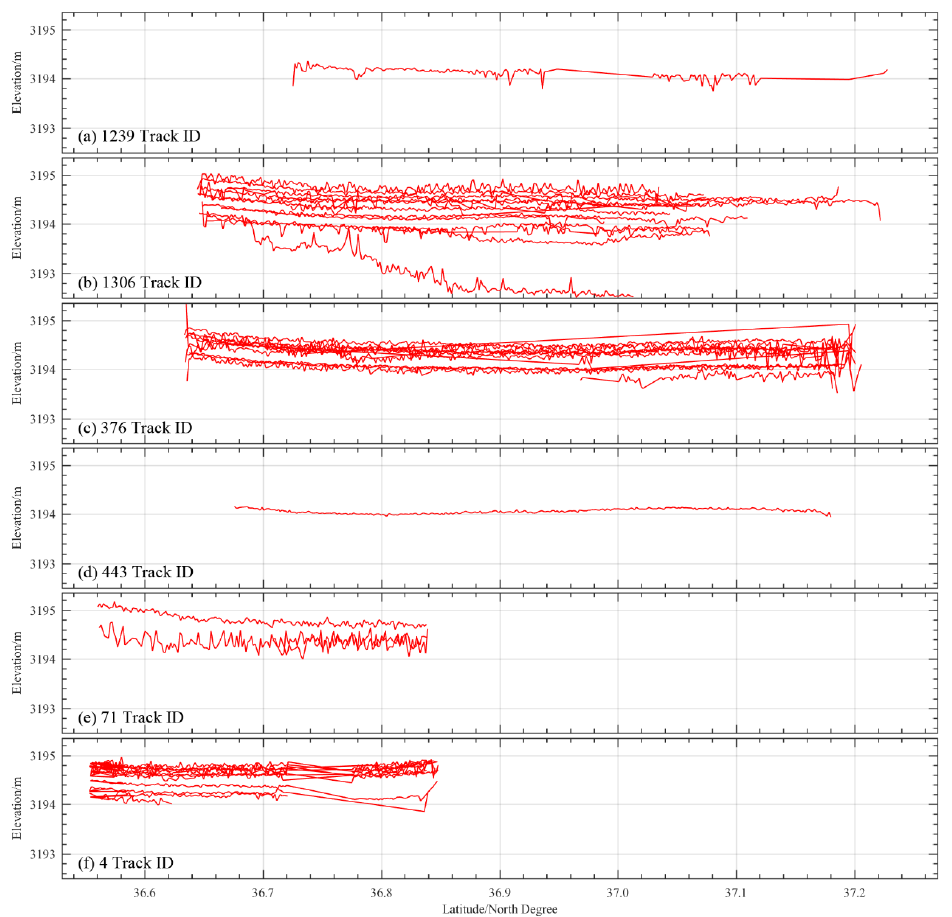
Figure 7. The elevation variation along the latitude in each track of ICESat, using the EGM2008 geoid and WGS84 reference ellipsoid.